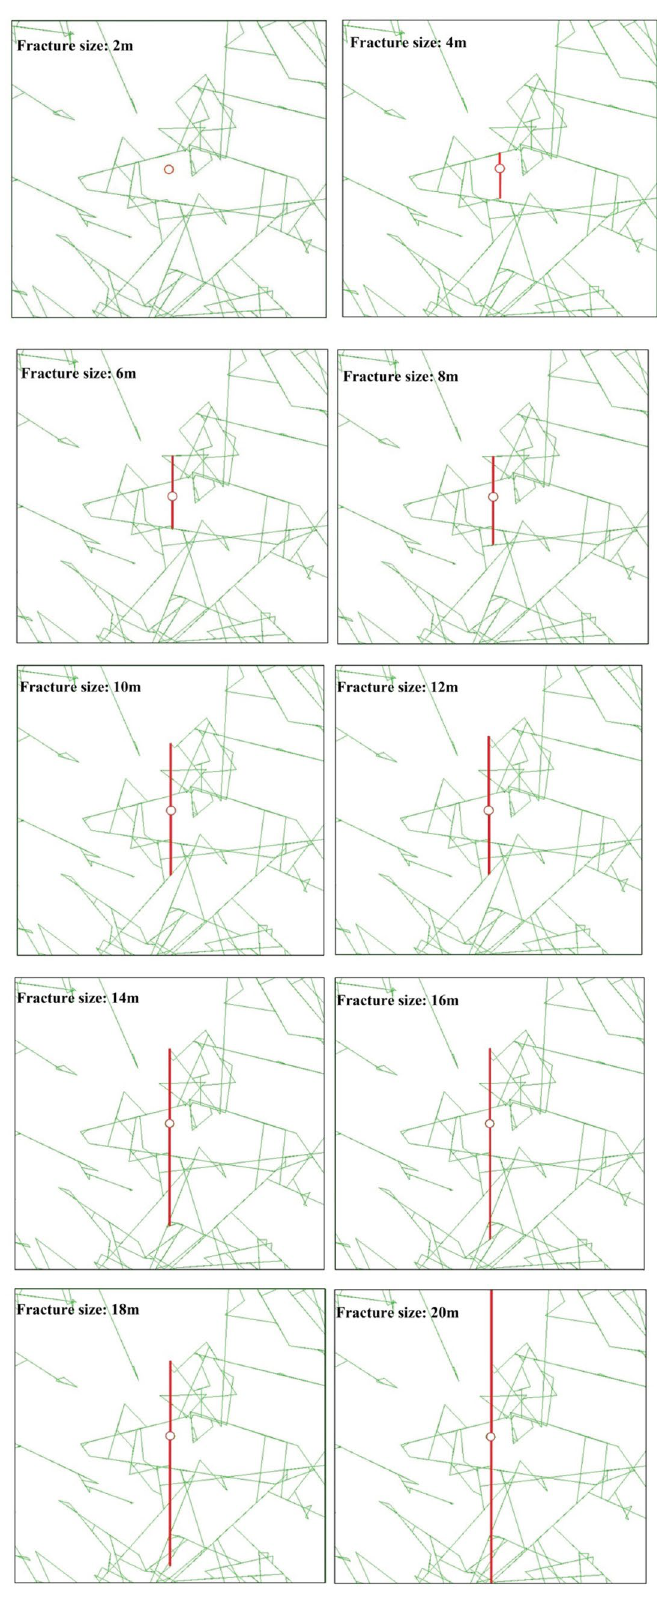
Fig. 11 Hydraulic fracture applied with different